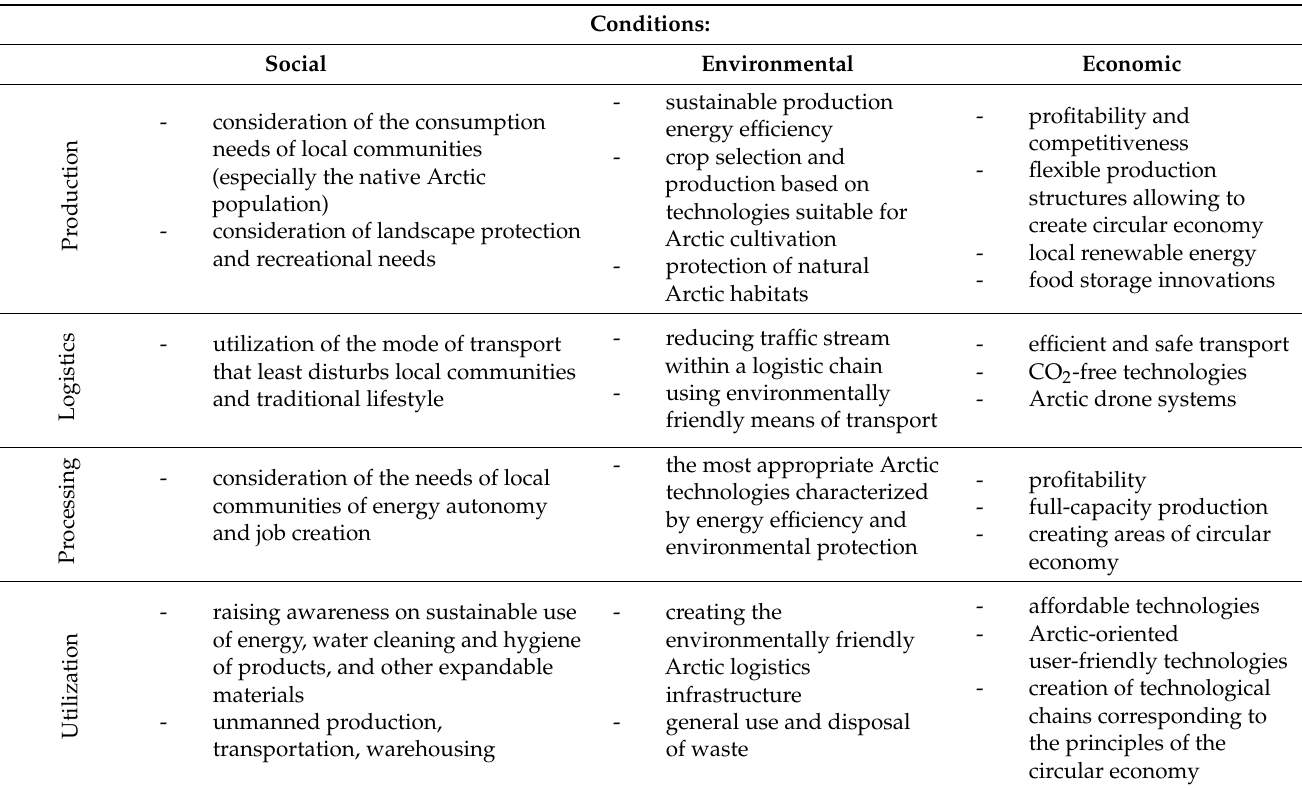
Table 3. Forecasting conditions for sustainable consumption and production in the Arctic, which is related to the model of the circular